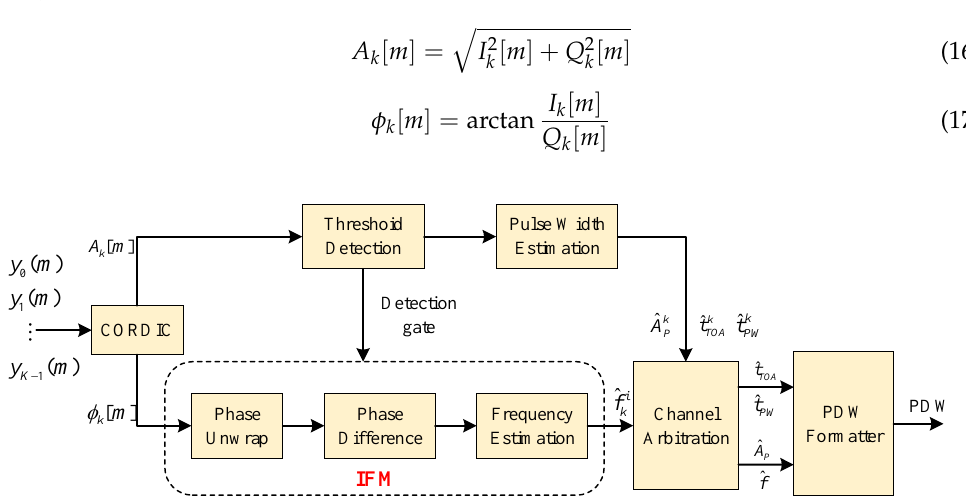
Figure 6. Channel detection, arbitration, and parameter estimation block